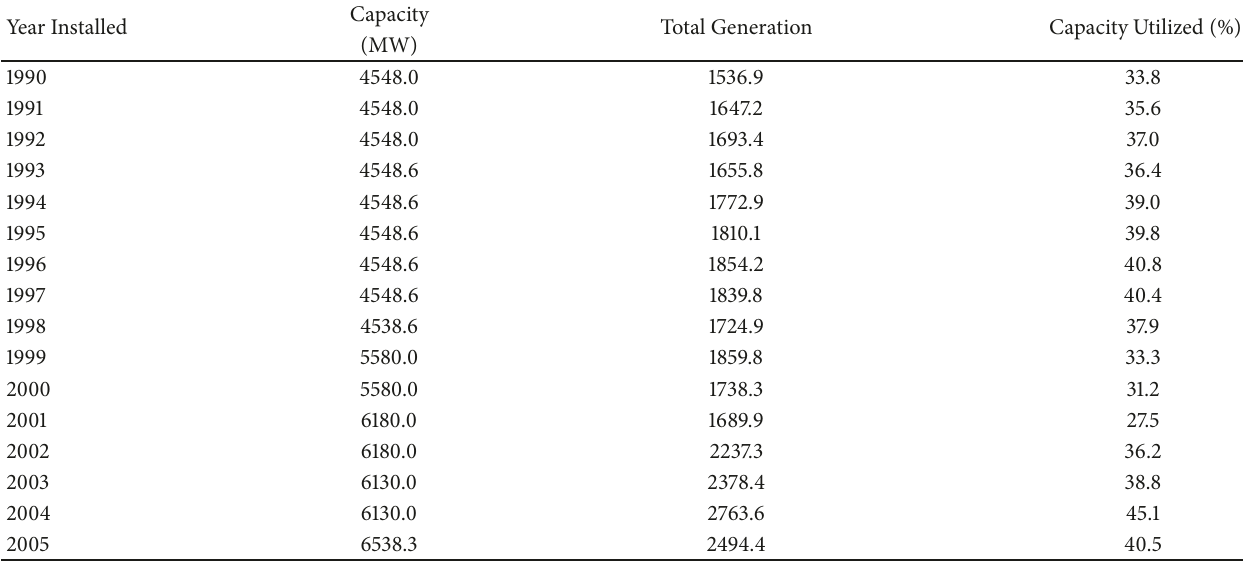
Table 1: Electrical generation and consumption in Nigeria.